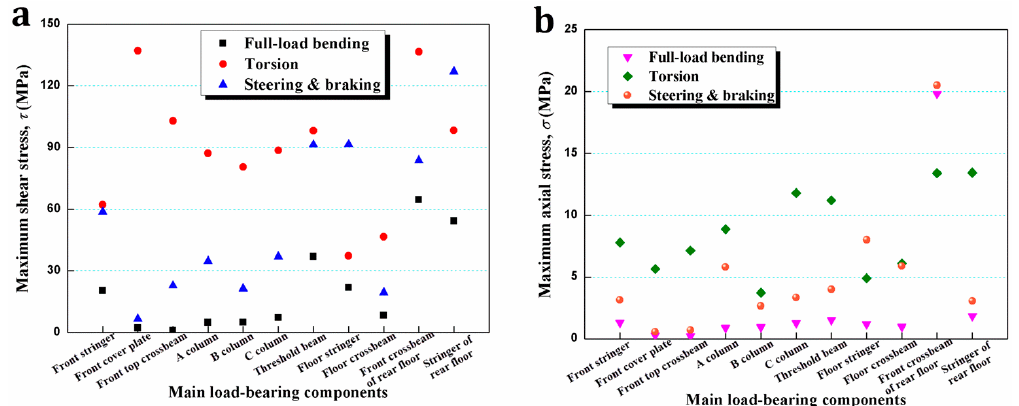
Figure 12. Maximum stress distributions of main load-bearing components under various operating conditions. ( a ) Shear stress τ ; ( b ) Axial stress σ .